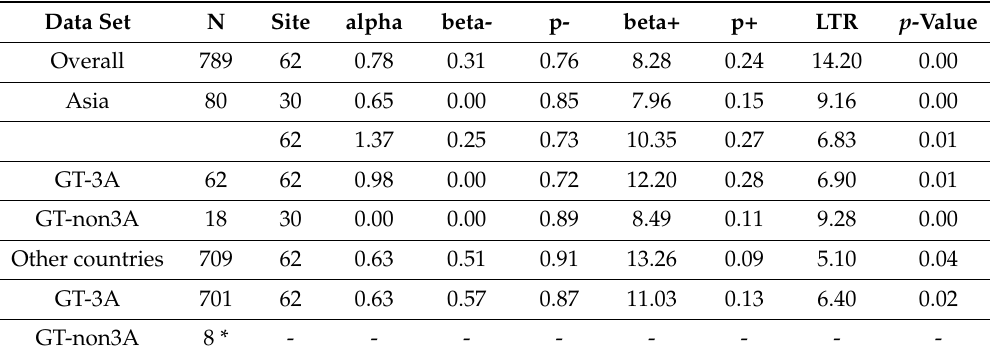
Table 3. Selective pressure analysis of NS5A domain 1 region according geographic origin and GT-3